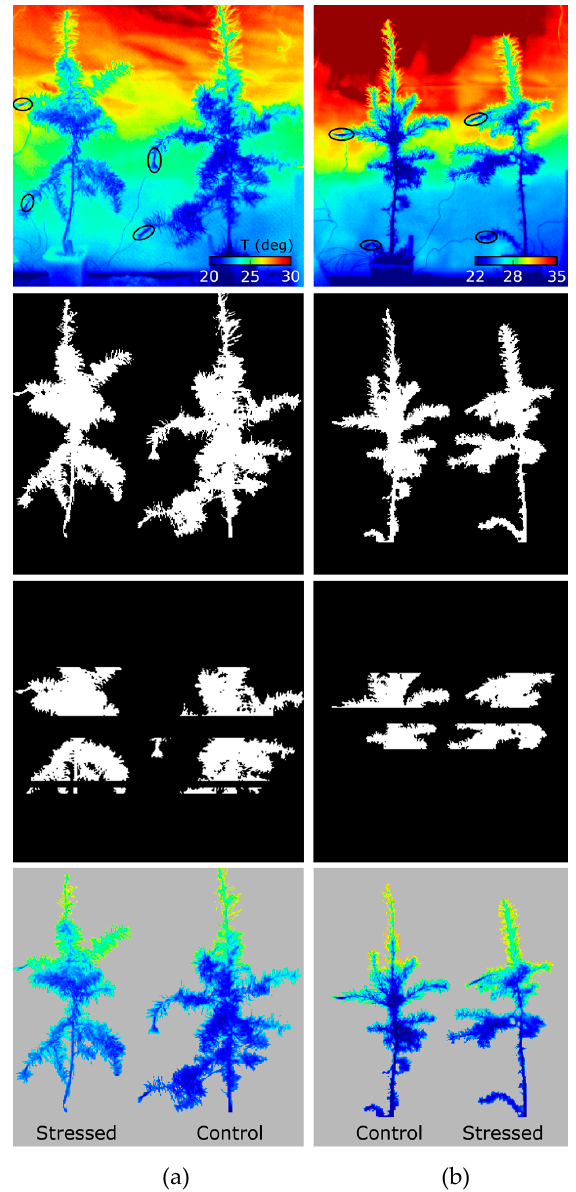
Figure 3. Canopy pixel extraction for: Experiment 1 ( a ); and Experiment 2 ( b ), showing original thermal image, the canopy mask, the low canopy volume mask, and extracted canopy pixels. Black circles indicate regions, where thermocouples were placed.